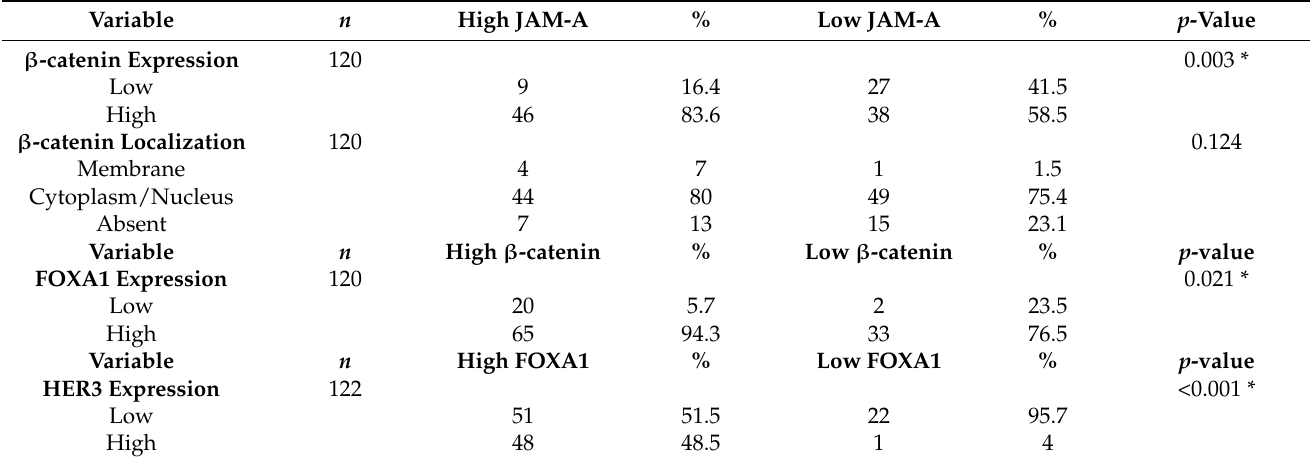
Table 2. Linear correlations between high versus low protein expression of JAM-A, β -catenin, FOXA1 and HER3 in breast cancer patient tissues. Studied variables, and their corresponding patient numbers, are shown in bold type. * denotes statistically-significant